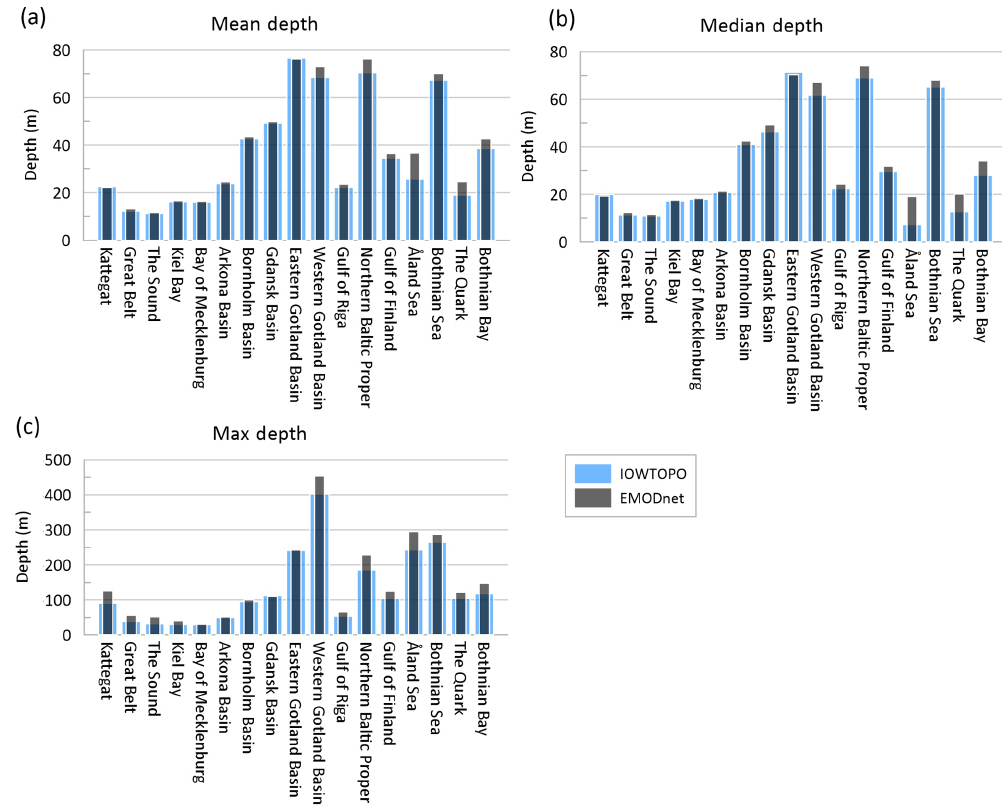
Figure 3. Comparison between mean, median, and maximum depths of the HELCOM-defined sub-basins based on the EMODnet (grey bars) and IOWTOPO (blue bars) DBMs. As for Table 1, note that the statistics are calculated from the DBMs’ grid cells, which have depths representing the mean within each grid-cell area. This implies, for example, that the maximum depth in each sub-basin will be slightly deeper than shown here. (a) Mean depth; (b) median depth; (c) maximum